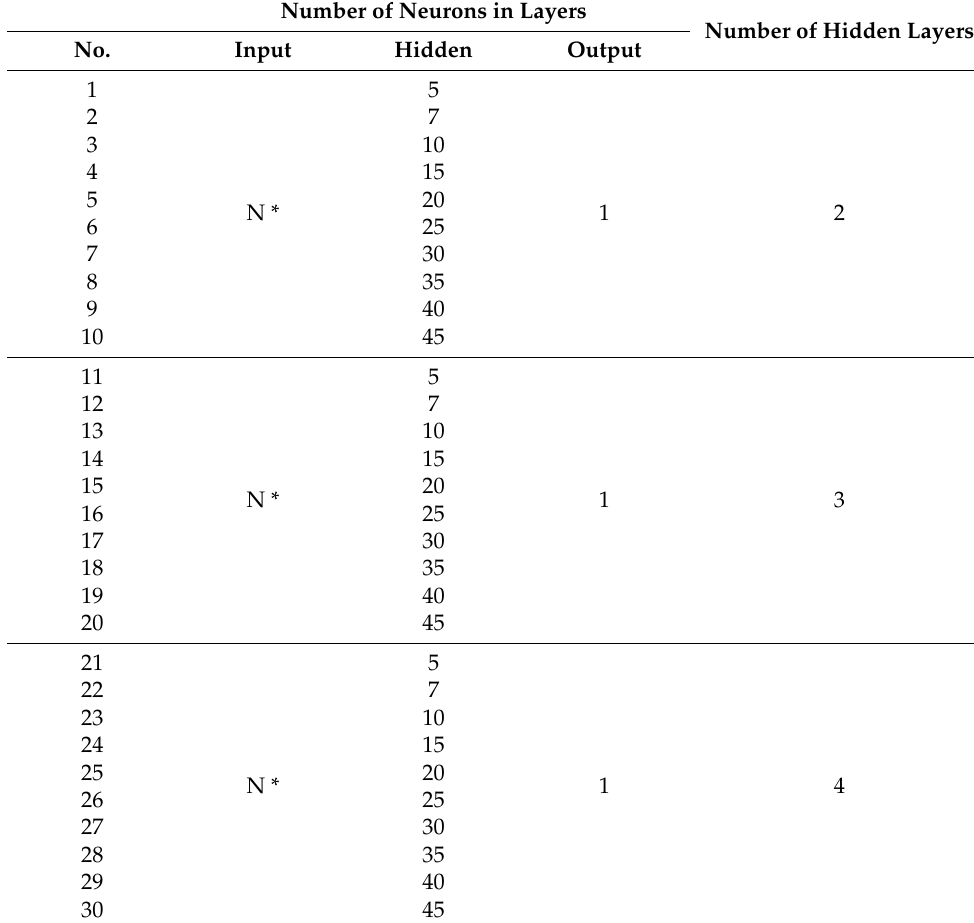
Table 6. Neural network structure, multipoint forecast.